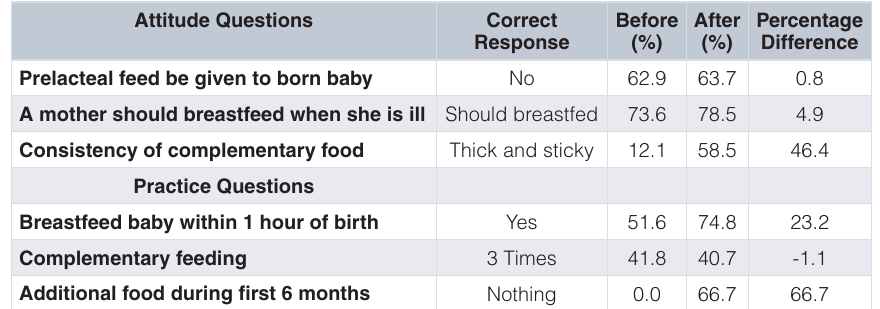
Table 4. Attitude & practices regarding infant and young child feeding (IYCF) nutrition among pregnant & lactating women in rural Islamabad, during 2016–2018 (n=135).